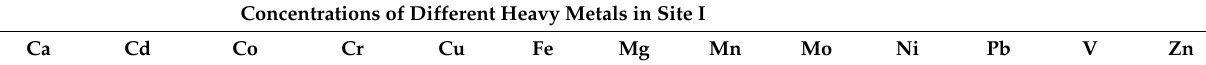
Table 6. Correlation between the concentrations of heavy metals in the soil samples of Site II